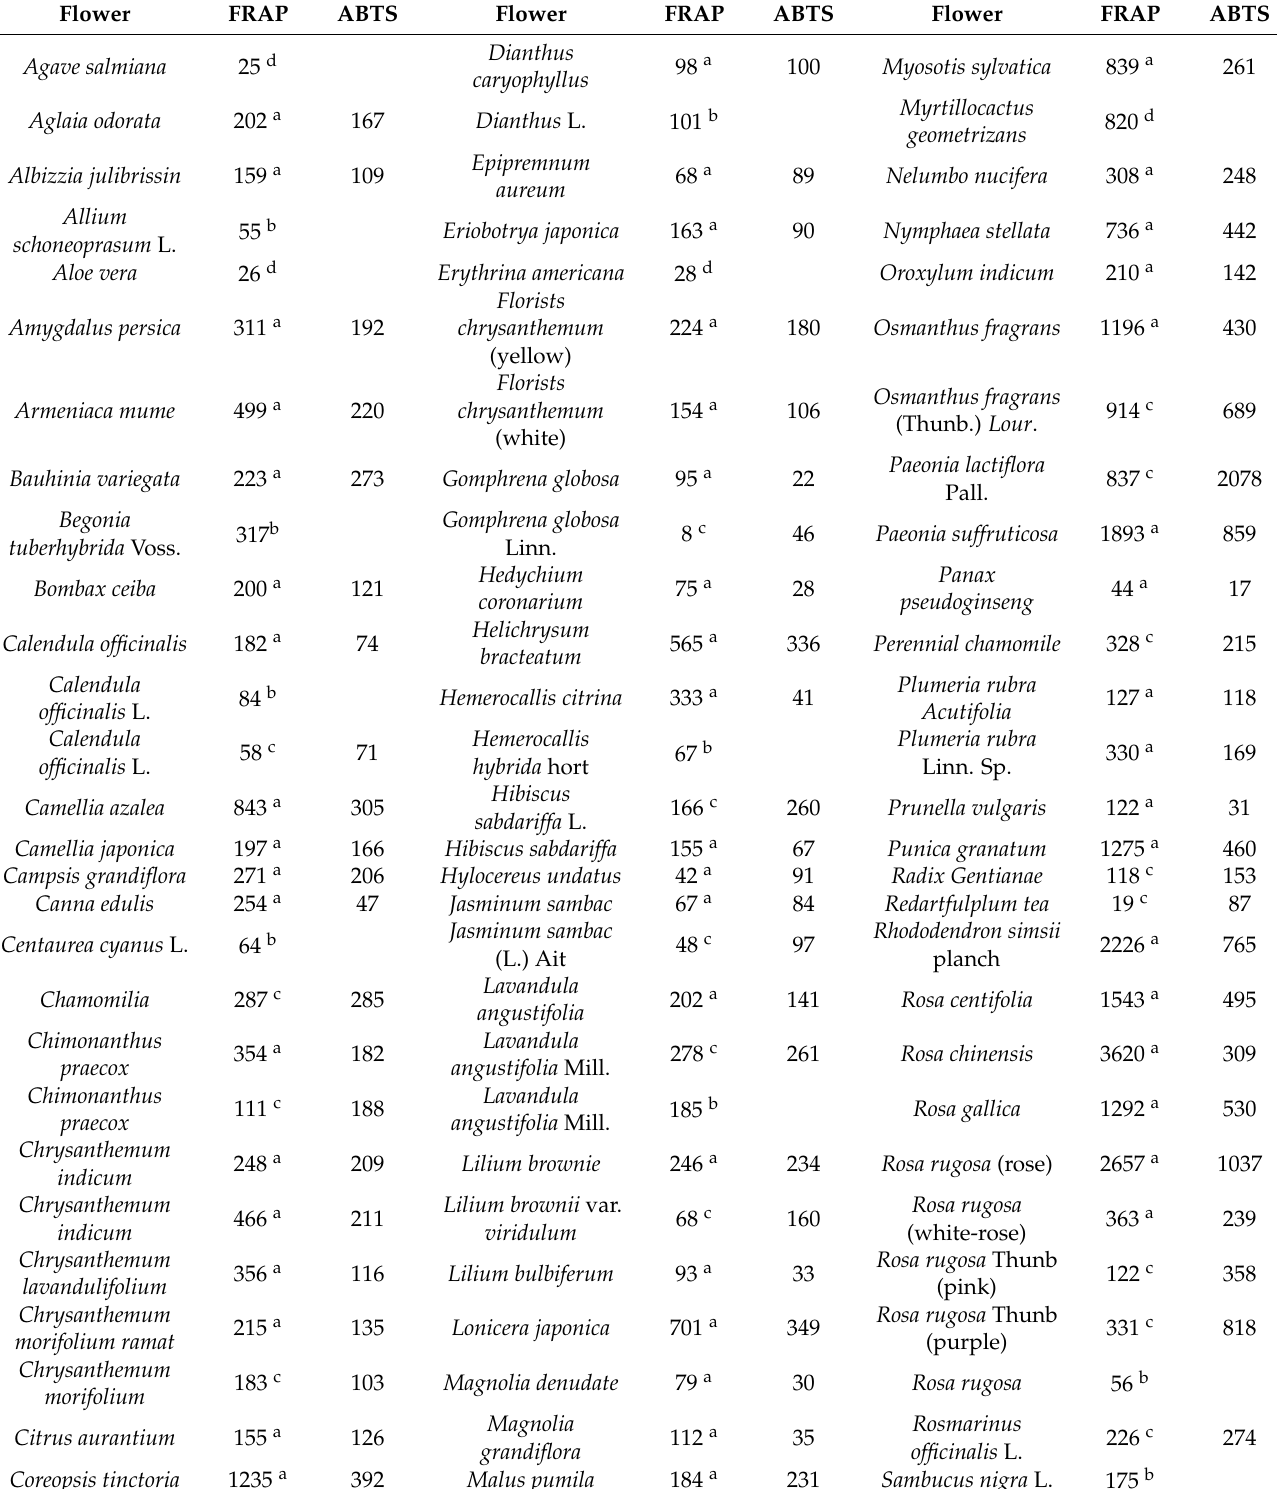
Table 12. Antioxidant activity (FRAP and ABTS in DW) of several edible